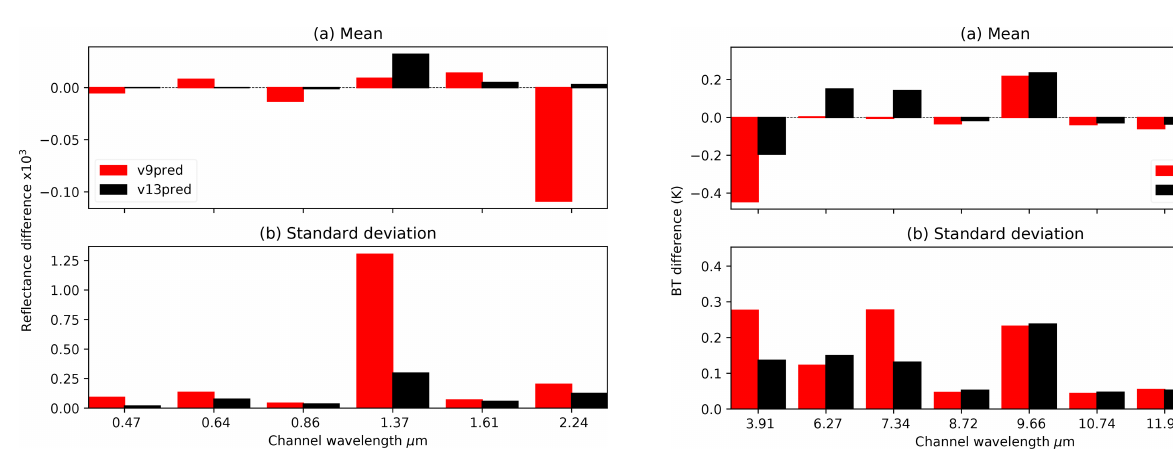
Figure 6. RTTOV vs. brightness temperatures calculated from channel-integrated LBLRTM radiances for MSG-4 SEVIRI IR channels for v9 and v13 predictors with variable O 3 and CO 2 for 5000 independent profiles with varying water vapour and O 3